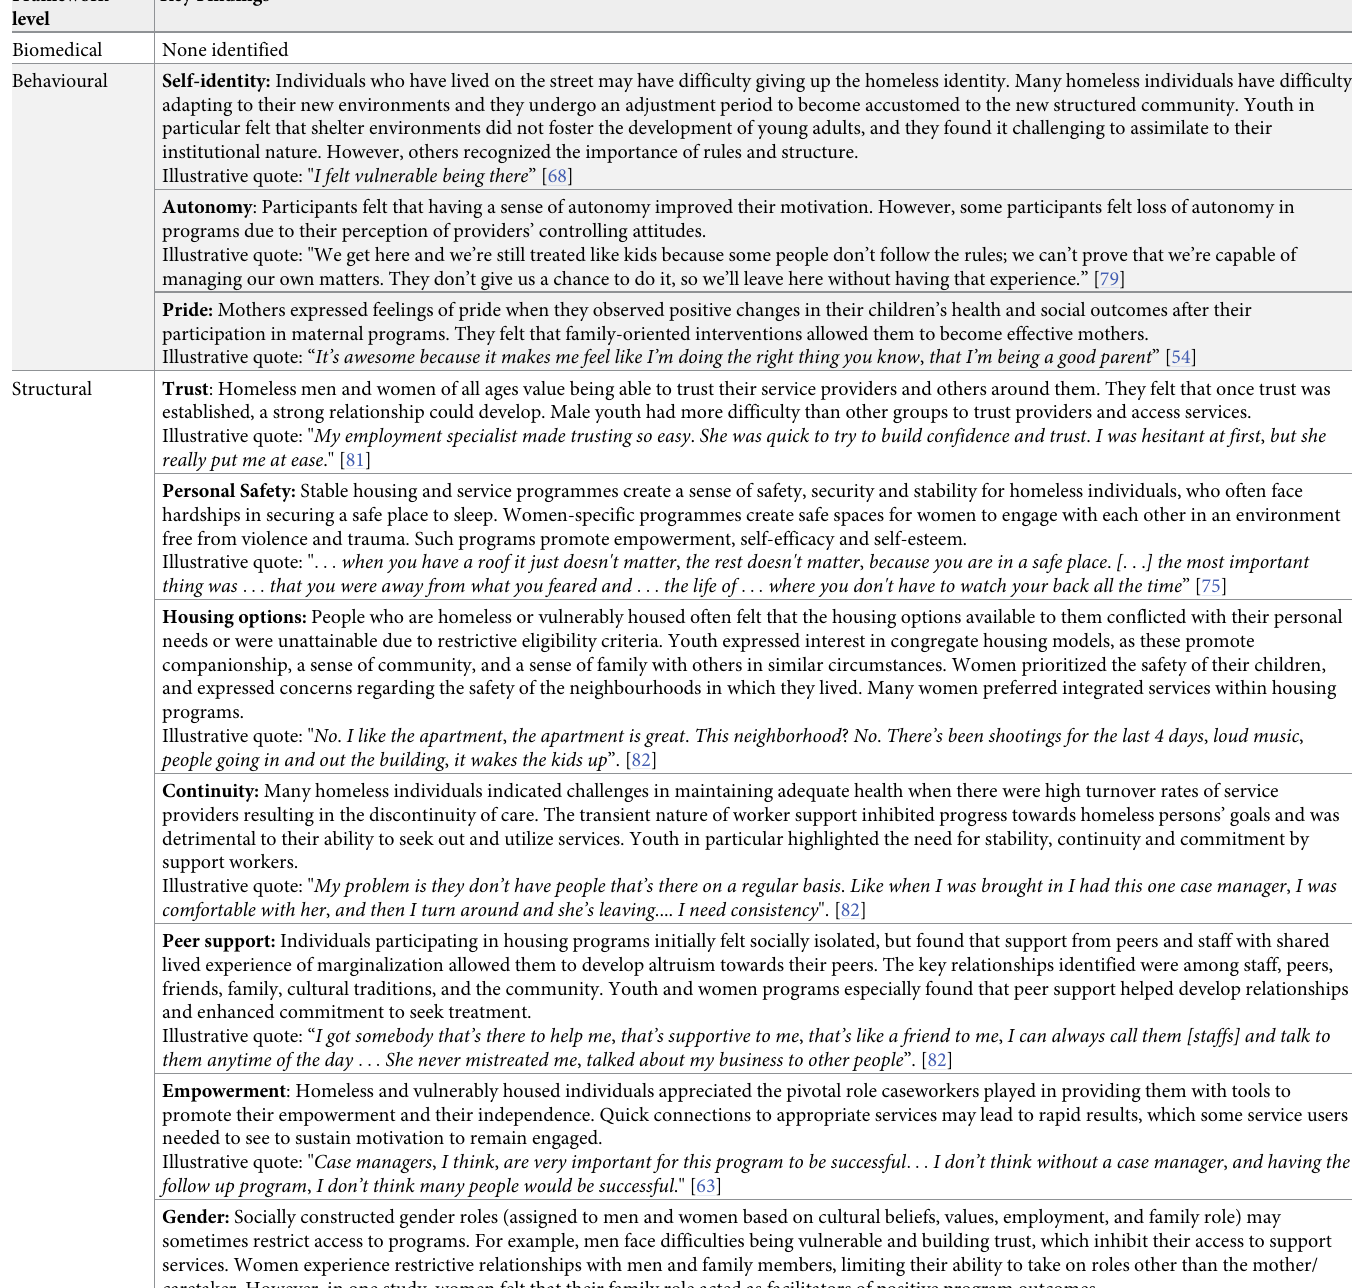
Table 4. Framework analysis key